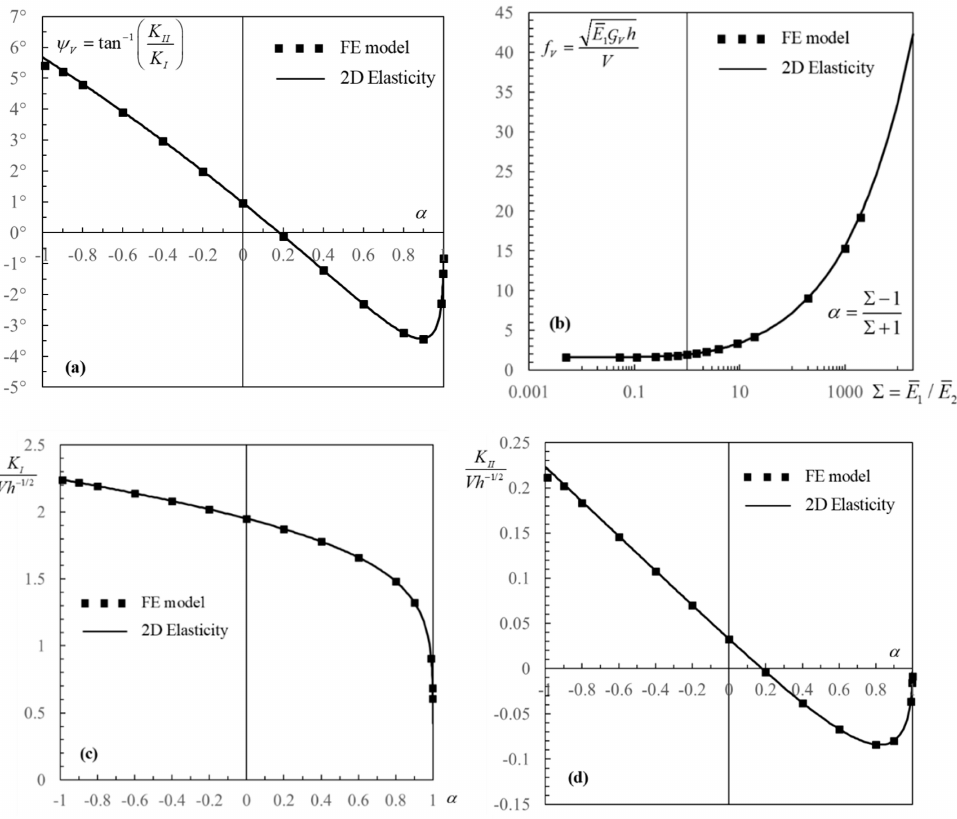
Figure 3. Fracture parameters in the edge-delamination crack in Figure 1 with V (cid:54) = 0, M = P = 0, and materials with β = 0; ( a ) the mode-mixity phase angle ψ V ; ( b ) the function f V defining energy release rate, logarithmic scale; ( c ) the mode I stress intensity factor; ( d ) the mode II stress intensity